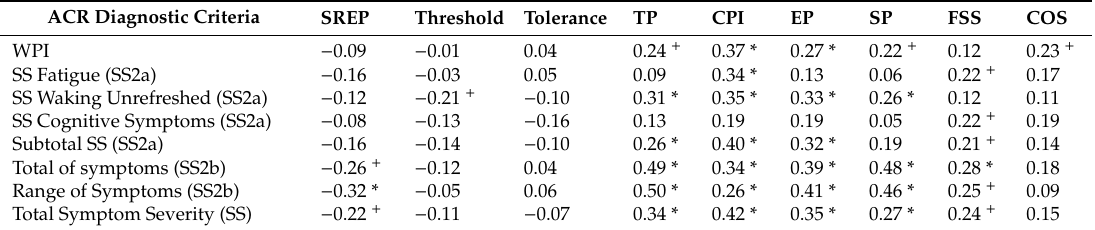
Table 4. Correlations of WPI and SS with SREP, pain threshold, pain tolerance, clinical pain, fatigue and insomnia in FMS patients ( n = 102).